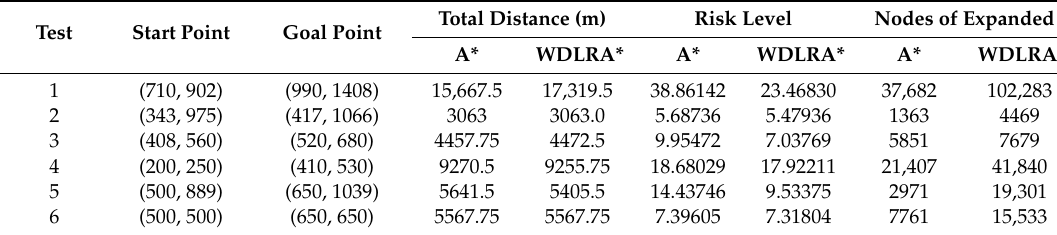
Table 7. Comparison of different starting and goal points.